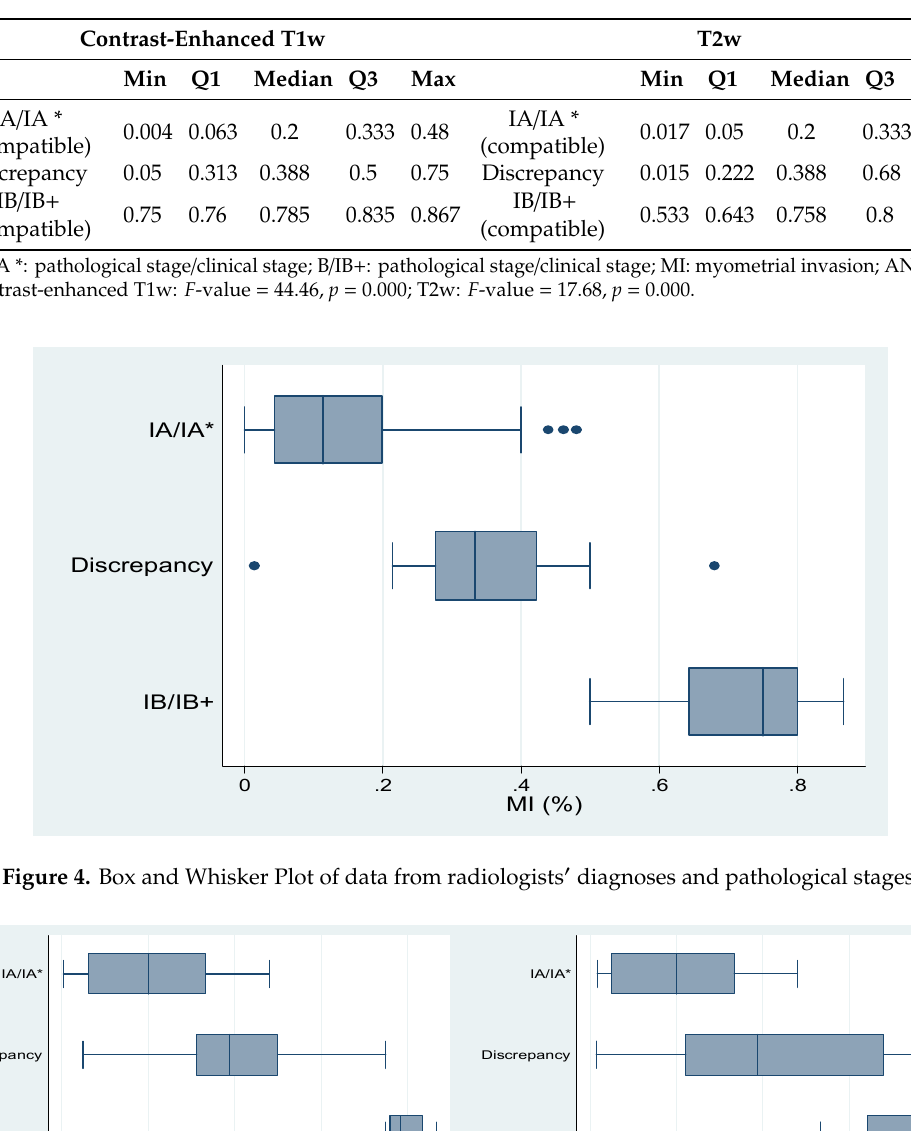
Table 4. Results of radiologists′ diagnoses and pathological stages.